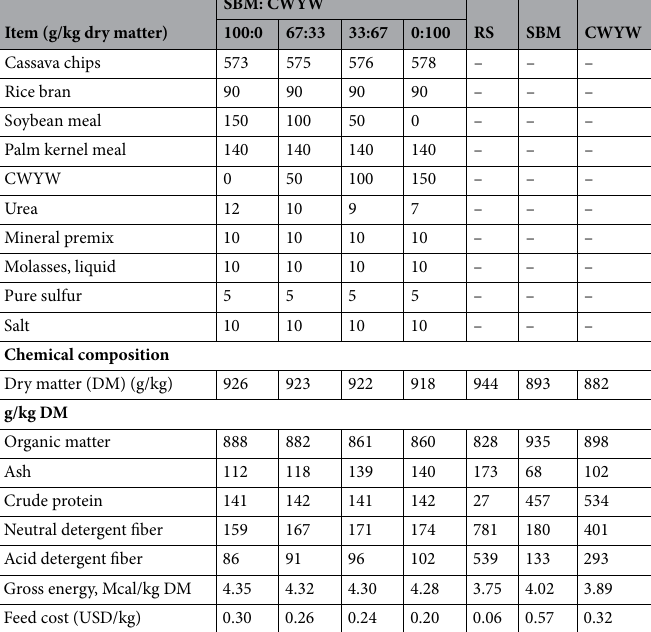
Table 1. Ingredients and chemical compositions of experimental dietary. SBM: CWYW replacing soybean meal with citric waste fermented yeast waste ratio, RS rice straw, SBM soybean meal, CWYW citric waste fermented yeast